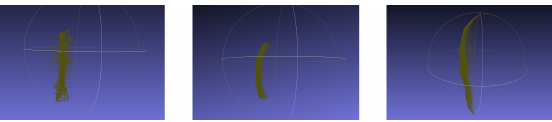
Figure 7. Results of sphere reconstruction. (left-SGBM, middle-DispNet, right-ZED